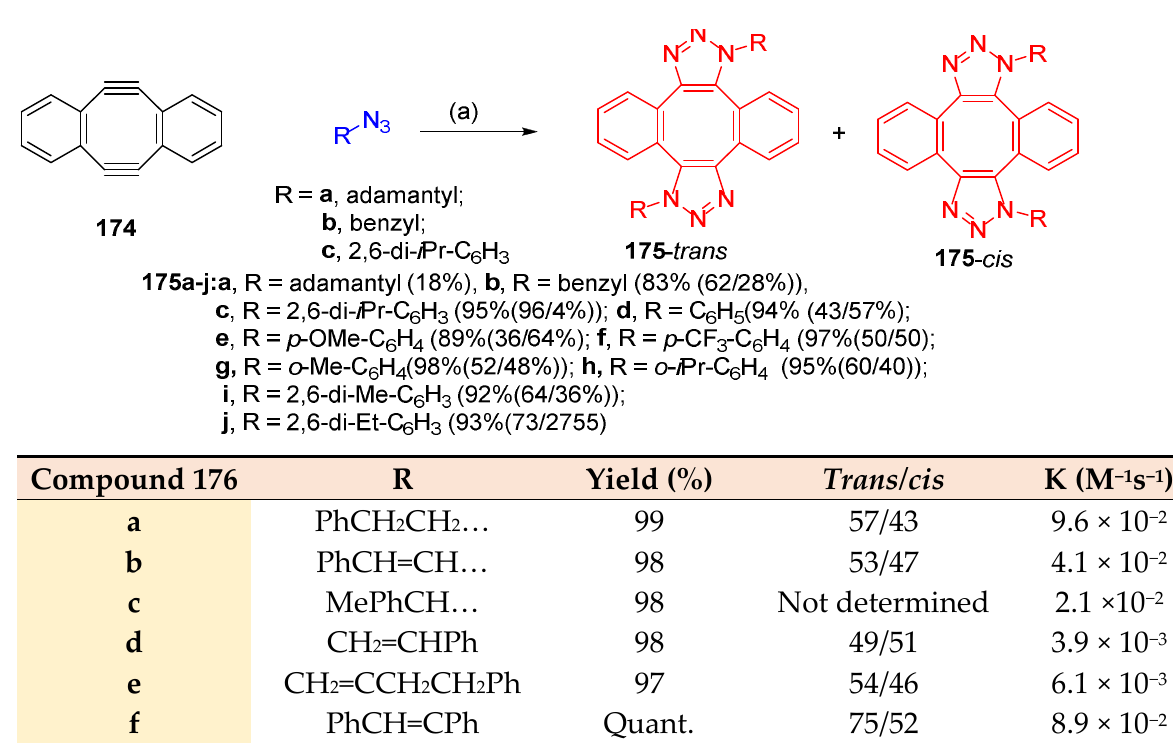
Scheme 67. Cycloaddition of Sondheimer diyne 174 with aryl azides. Reagents and conditions : (a) 2.4 equiv. of azide, MeOH room